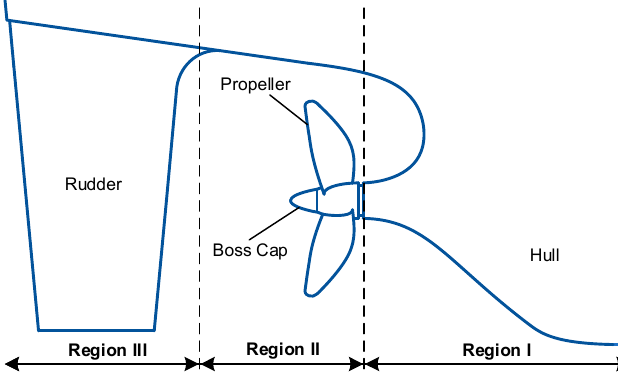
Figure 1. Classification of the regions for aftship energy saving devices.